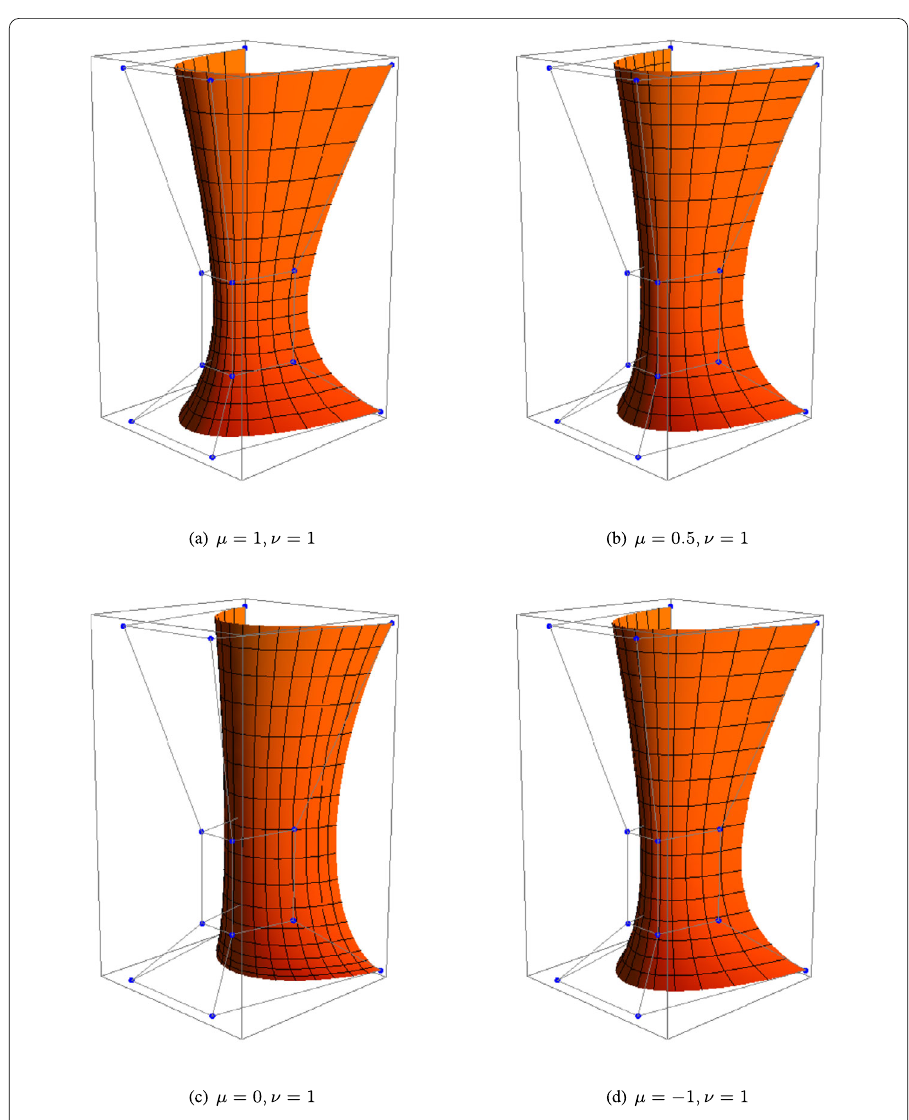
Figure 14 GBT-Bézier swung surfaces with different shape parameter μ